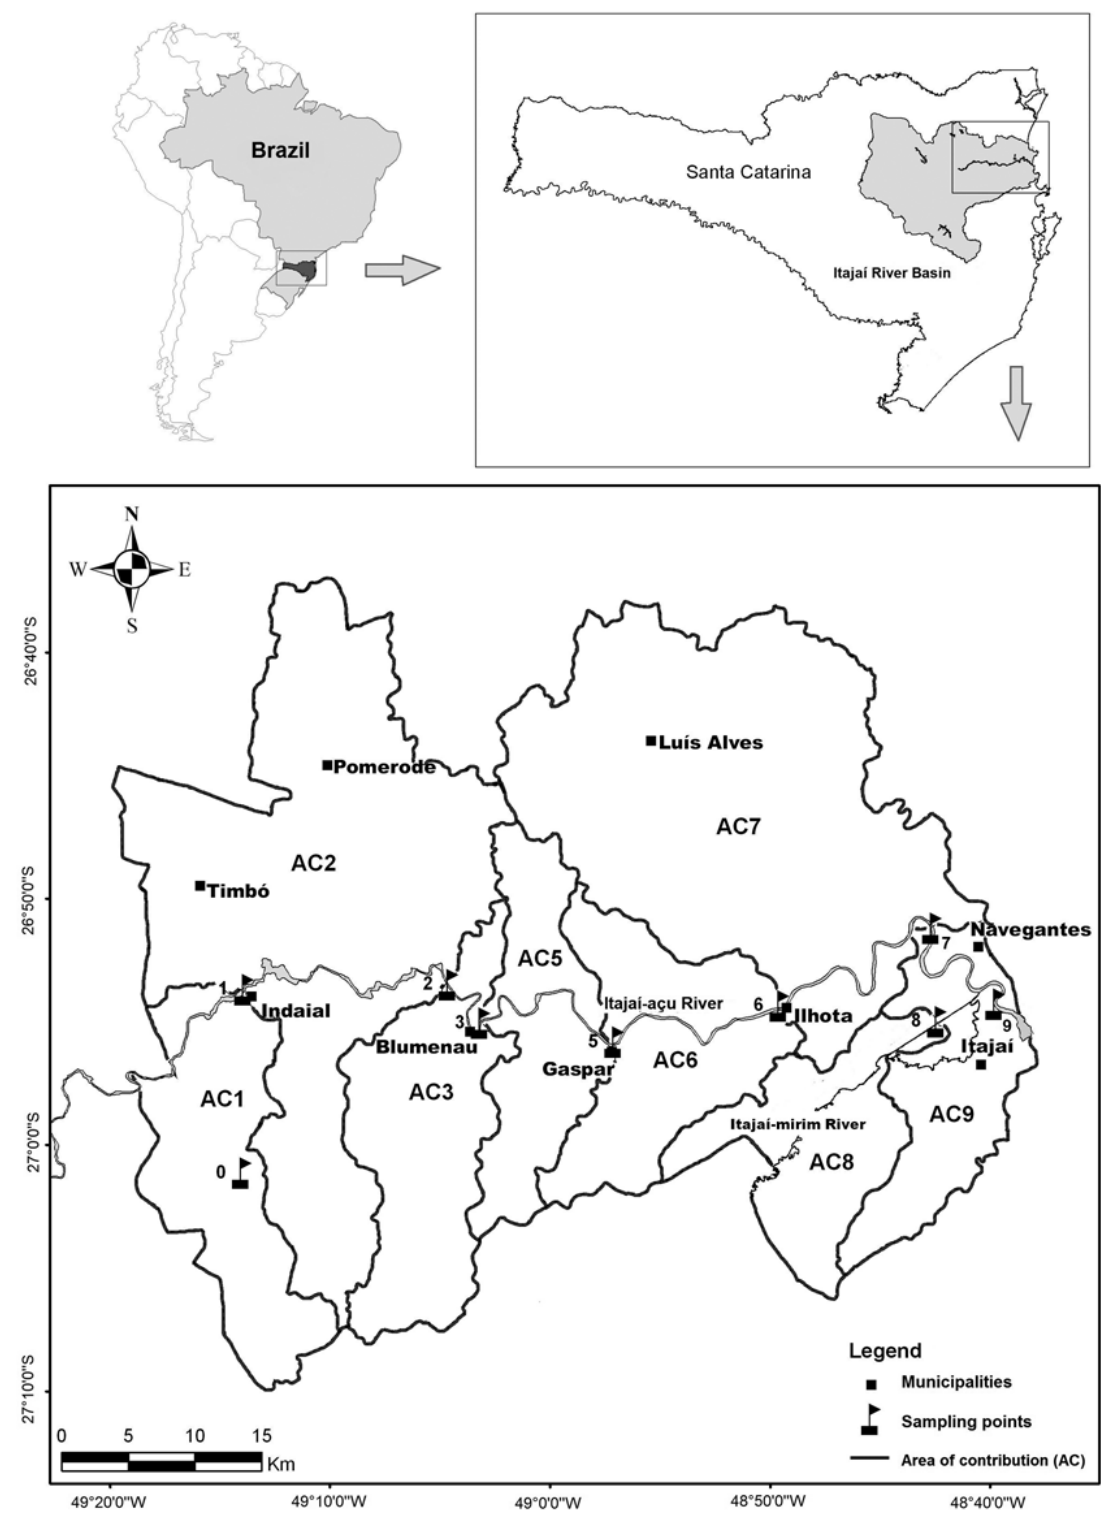
Fig. 1–Areaofthestudy, showingcollectionstationsalongtheItajaí-AçúRiverestuary, SC.Thedivisionofthefinalportionofthebasinrepresents the areas of contribution for each sampling station used to delimit the land